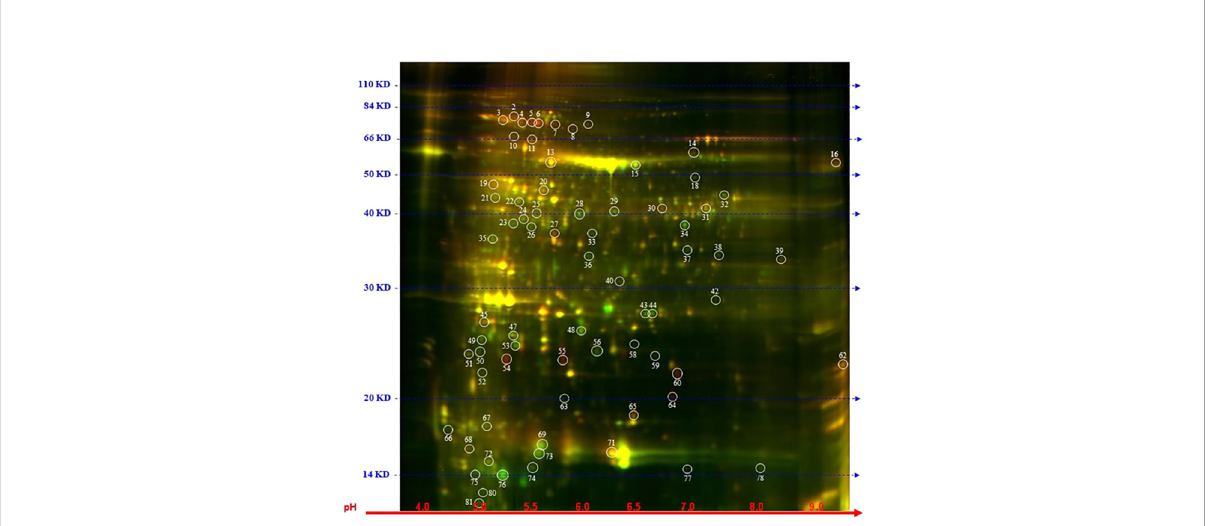
FIGURE 5 Distribution of differential proteins identi fi ed on 2D-DIGE gel. Proteins from untreated samples were labeled with Dy3 (green)and samples treated with SPC were labeled with Dy5 (red). Images were analyzed with Image Quant software to detect the differentially expressed protein spots, marked with circles (Student ’ s t-test, p ≤ 0.05). Numbers indicate spots that signi fi cantly differ at 48 h compared to the